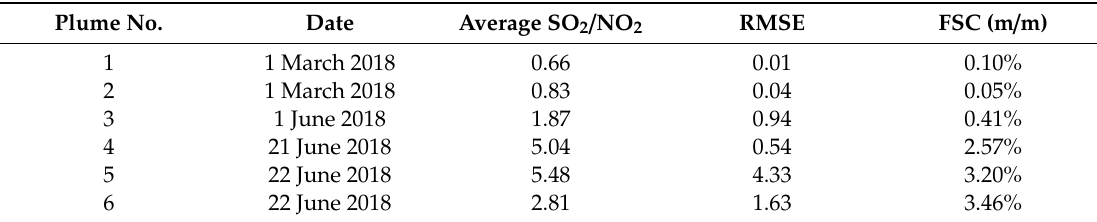
Table 1. Average and root-mean-square error (RMSE) of the SO 2 / NO 2 ratio in six plumes and fuel sulfur content (FSC), where m / m is mass by mass. Plume